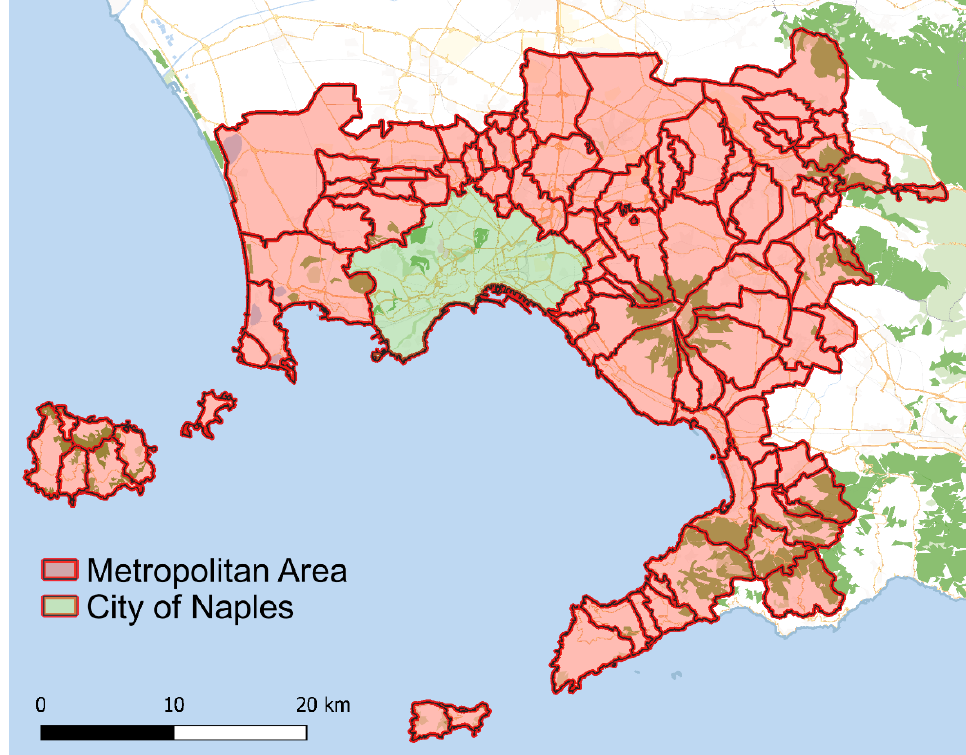
Figure 1. The study area of the Metropolitan City of Naples. The red borders highlight the 91 municipalities of the former Province of Naples (in red) and the City of Naples (in green).